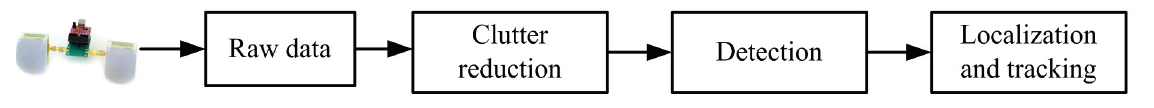
Figure 1. Signal processing for localizing and tracking a moving